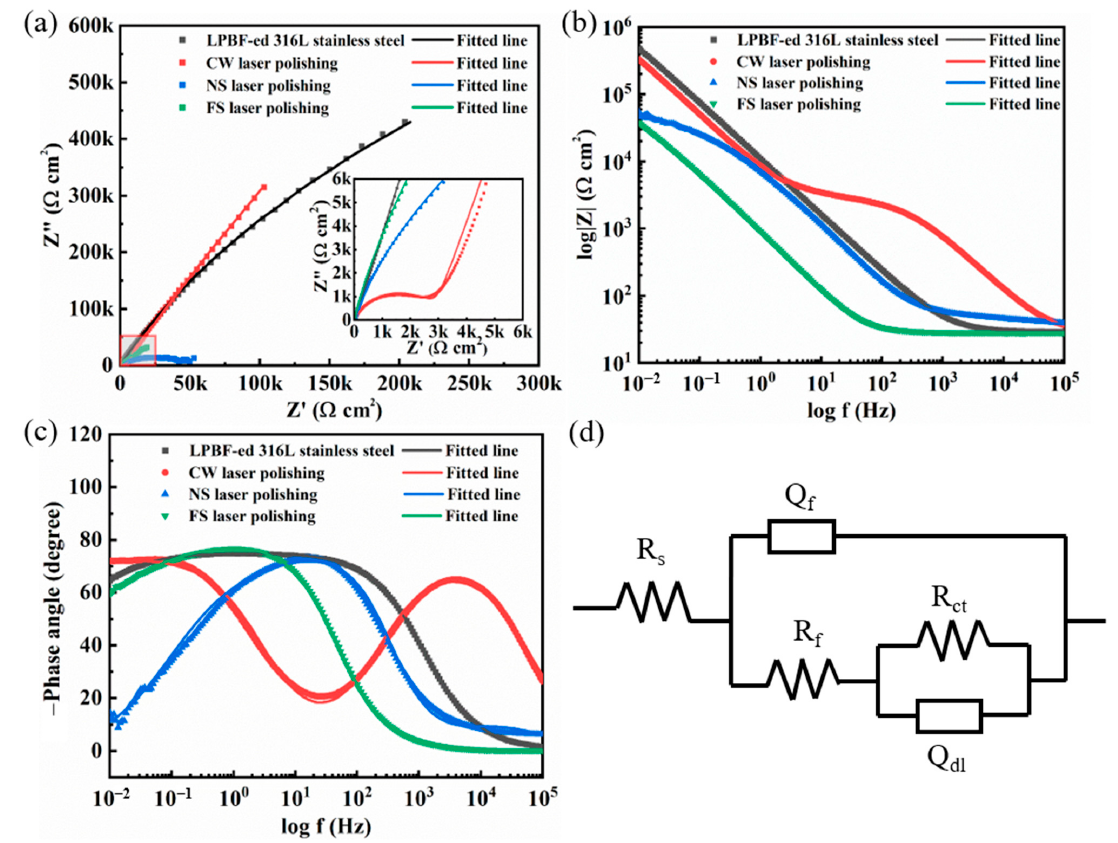
Figure 10. Measured and simulated ( a ) Nyquist curves, ( b ) Bode impedance, and ( c ) Bode phase angle of original and laser-polished samples. ( d ) Electrochemical equivalent circuit model.